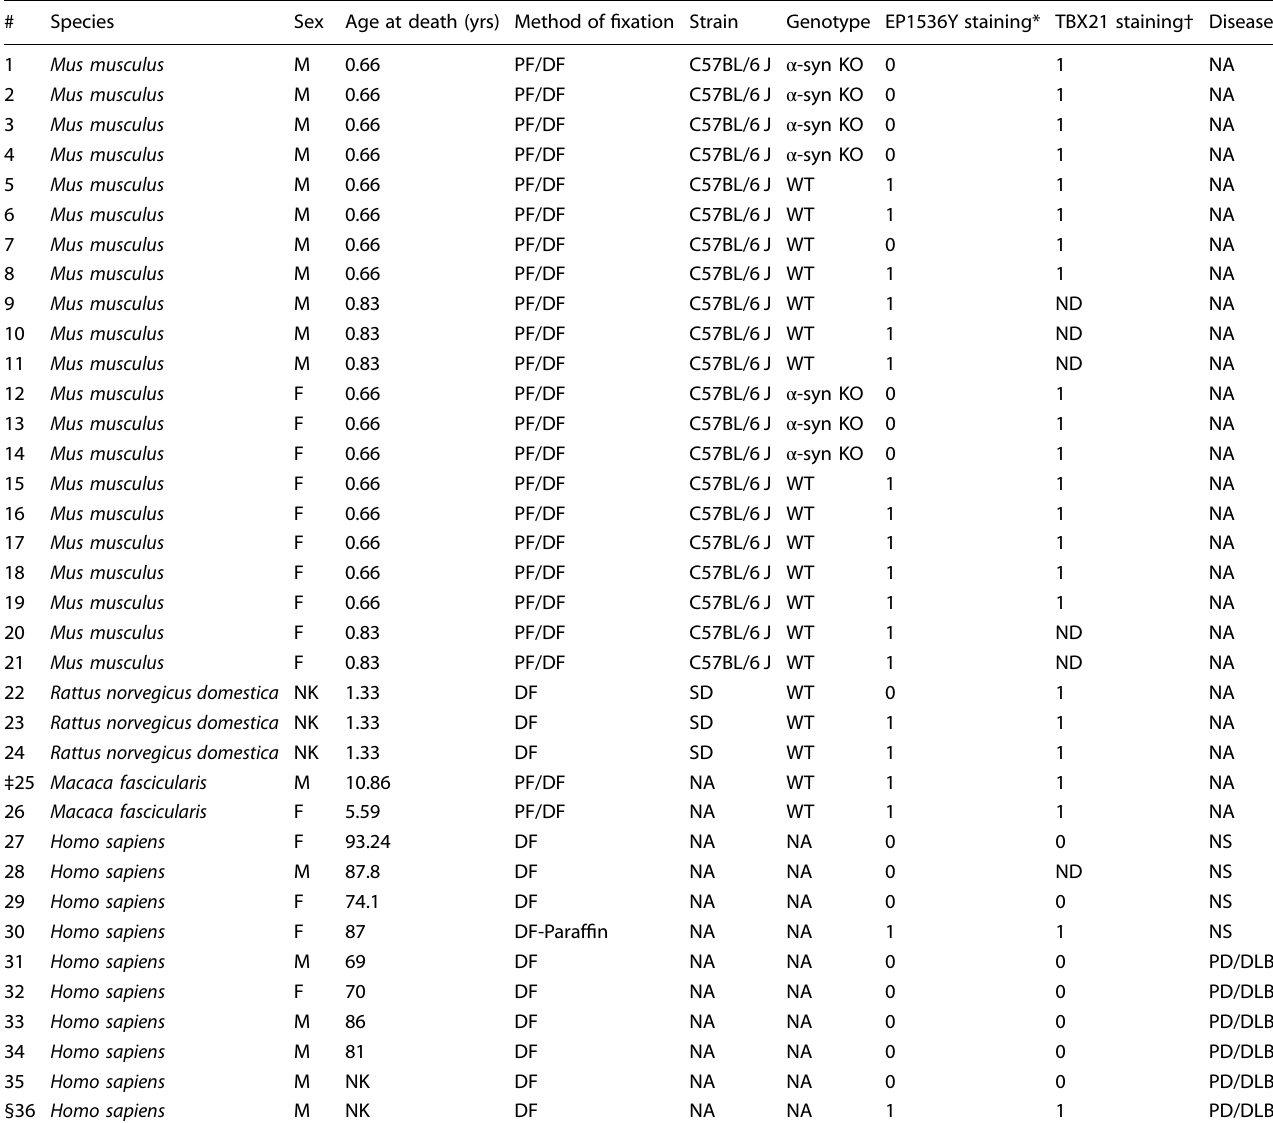
Table 1. List of specimens and summary of